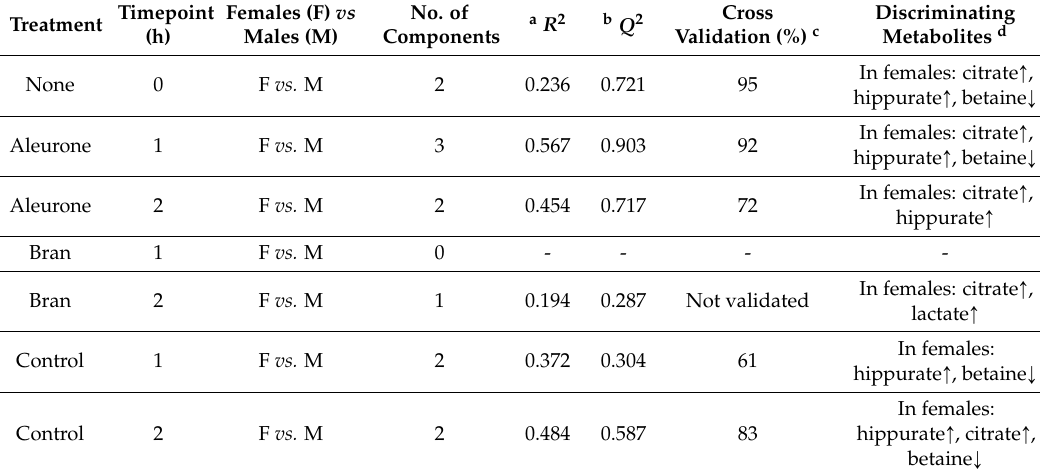
Table 4. Comparison between the sexes for urinary metabolite profiles after different treatments at different